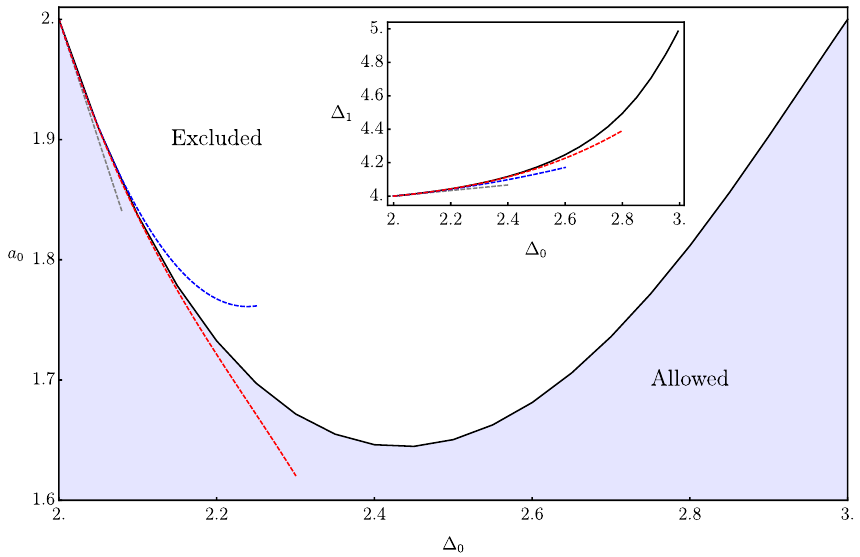
Figure 5 . OPE maximization at (cid:1) (cid:30) = 1 with N = 19 components, although no visible changes are seen beyond N = 5. Main plot: bound on the OPE coe(cid:14)cient of the (cid:12)rst operator as a function of its dimension (cid:1) . Inset: dimension of the second operator (cid:1) 0 In both plots, the dashed lines represent analytic perturbation theory computations up to cubic order in g (cid:17) (cid:1) (cid:0) 2(cid:1) (cid:30) , as described in the main 1